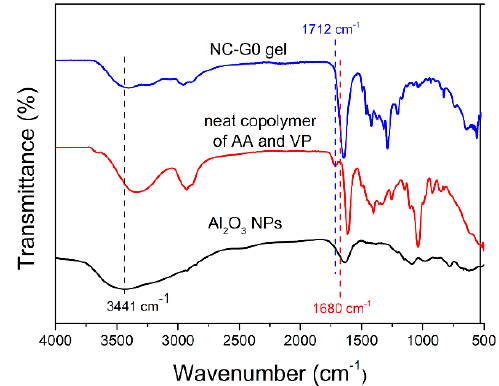
Figure 2. Fourier transform infrared (FTIR) spectra of alumina nanoparticles (Al 2 O 3 NPs), neat copolymer and NC-G0 gel.